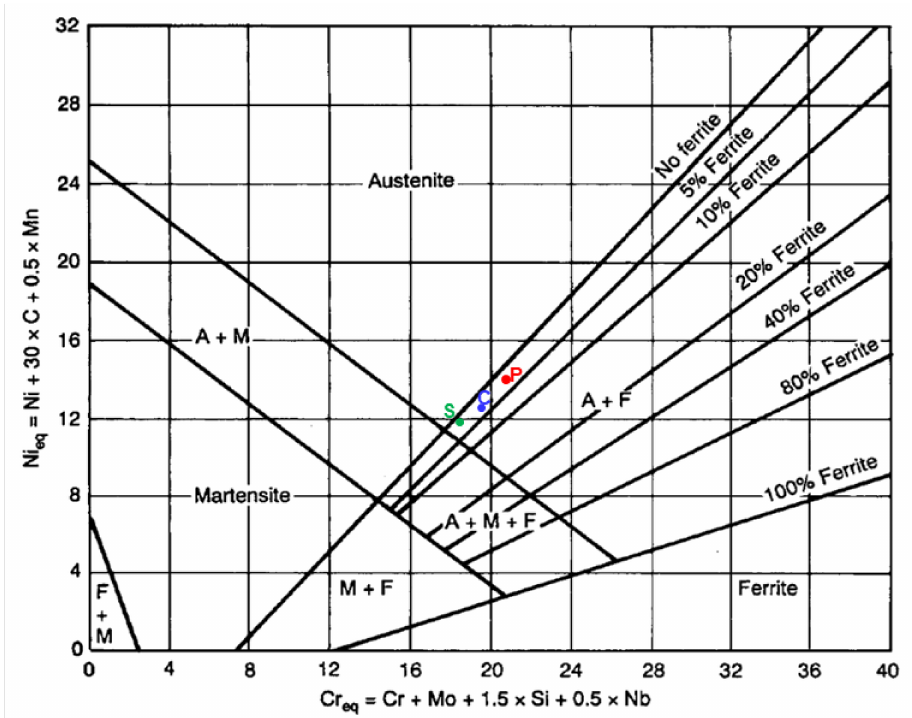
Figure 4. Schaeffler constitution diagram [27] showing the location of the AISI 316 powder (P), AISI 347 substrate (S), and AISI-316-steel-deposited layer (C)